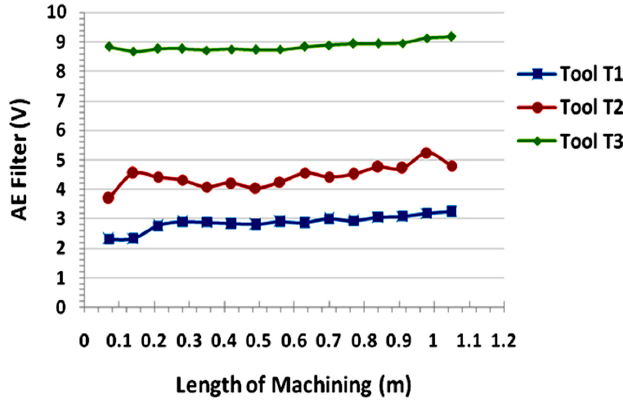
Figure 9. AE Out (filter) values Vs Length of machining for different tools.